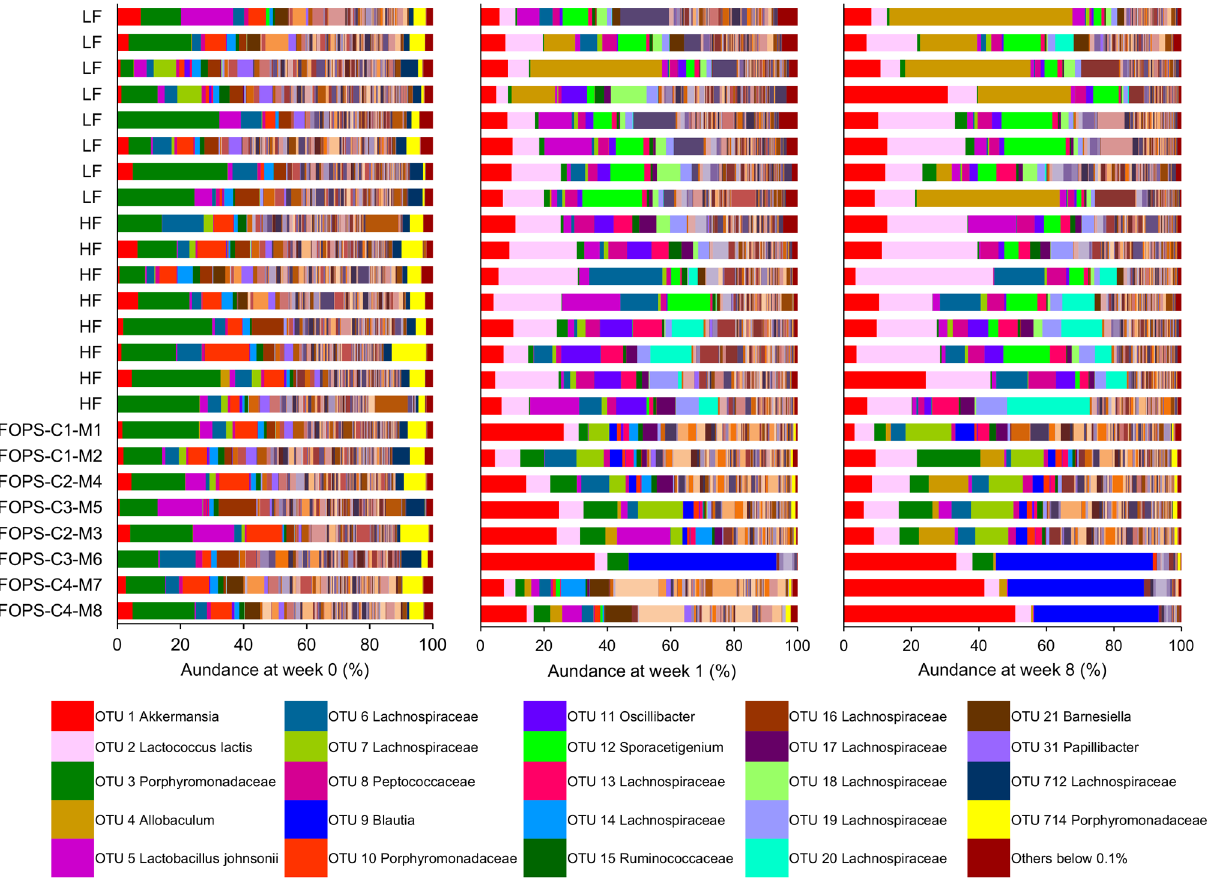
Fig 7. Fecal microbiota compositions based on OTU abundance for each mouse after 0, 1, and 8 weeks of feeding. For FOPS mice, C1, C2, etc. indicate cage 1, cage 2, etc., while M1, M2, etc. indicate mouse 1, mouse 2, etc.; the color key corresponds to the 25 most abundant OTUs across all time